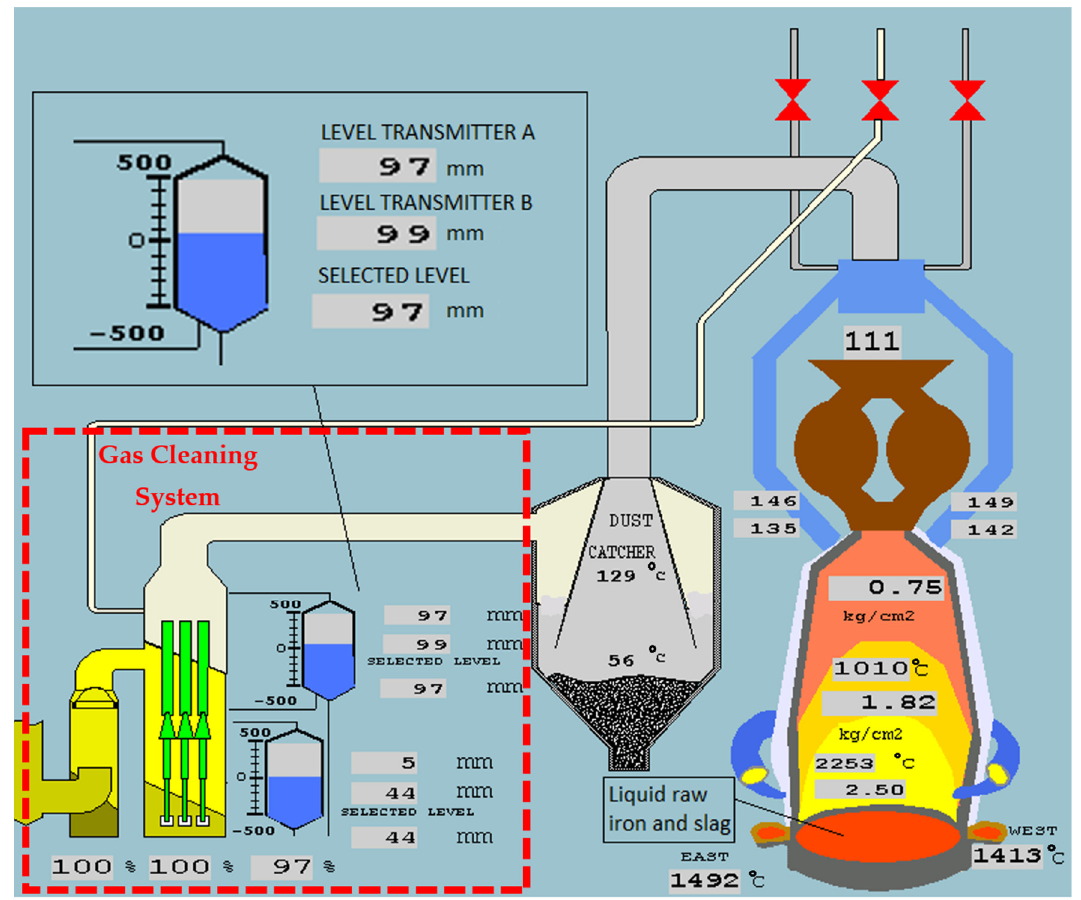
Figure 1. Blast furnace and gas cleaning